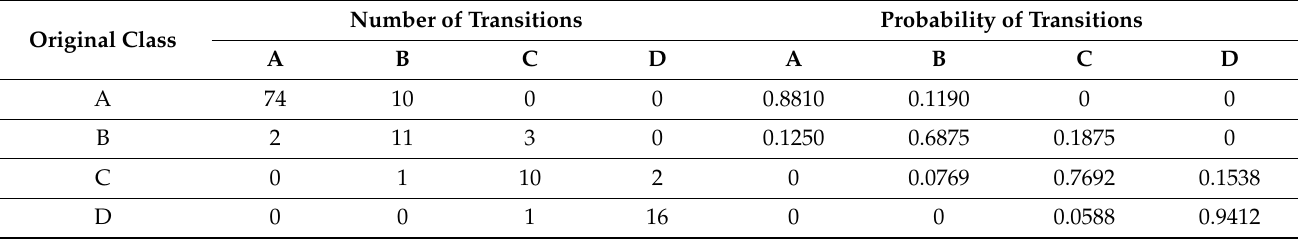
Table 2. The transition matrix for the evolution of urban size, measured with total night-time light, in YREB during